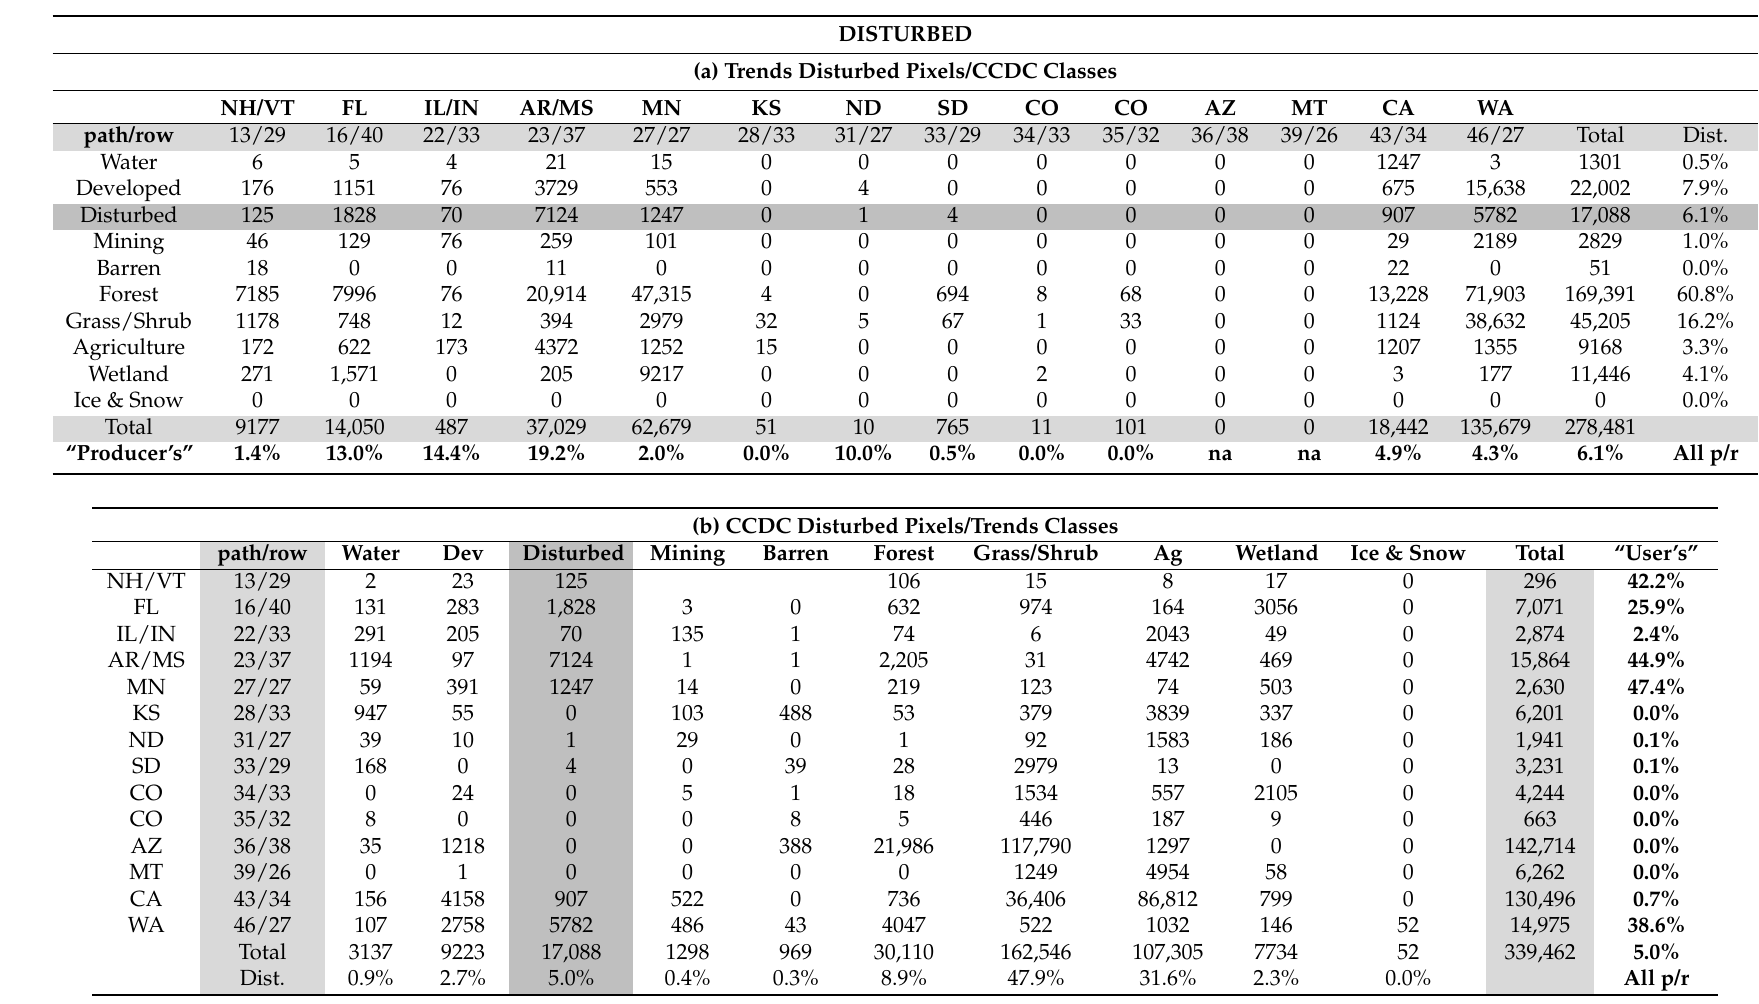
Table 13. (a) LC Trends Disturbed pixels distributed across CCDC classes for each path/row location and (b) CCDC Disturbed pixels distributed across LC Trends classes for each path/row. AR = Arkansas; AZ = Arizona; CA = California; CO = Colorado; FL = Florida; IL = Illinois; IN = Indiana; KS = Kansas; MN =